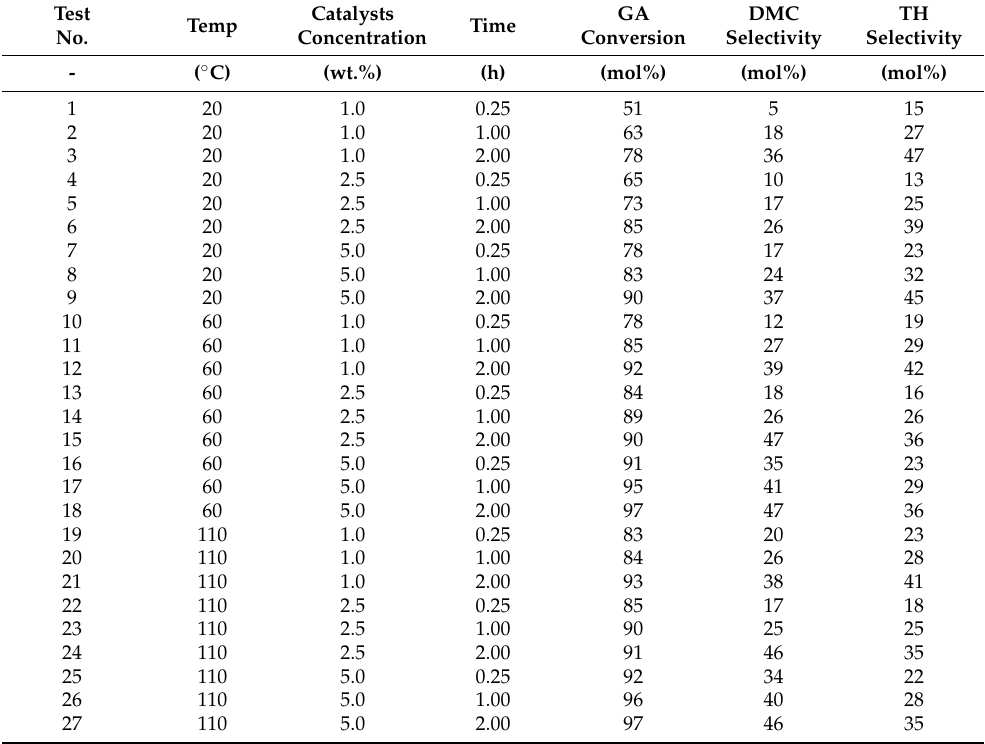
Table 4. Details of the conducted